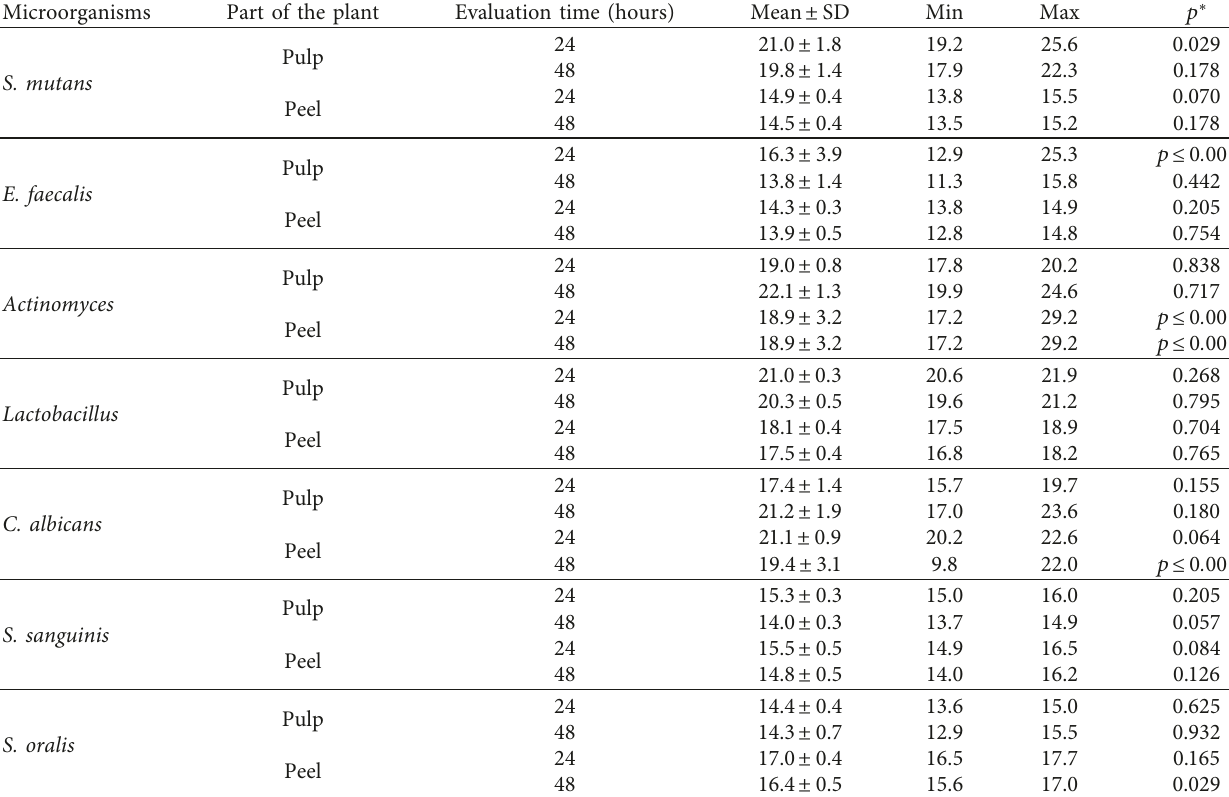
Table 3: Comparison of the antimicrobial activity of tumbo dentifrice against seven strains of the oral cavity (formulation with fluoride). Microorganisms Part of the plant Evaluation time (hours) Mean ± SD S. mutans